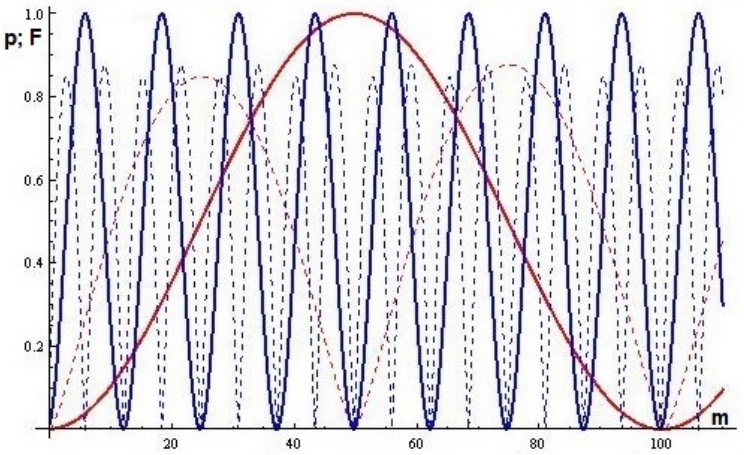
√ N , Renyi entropy: Red dashed √ N , r = 2, a = 0.7.